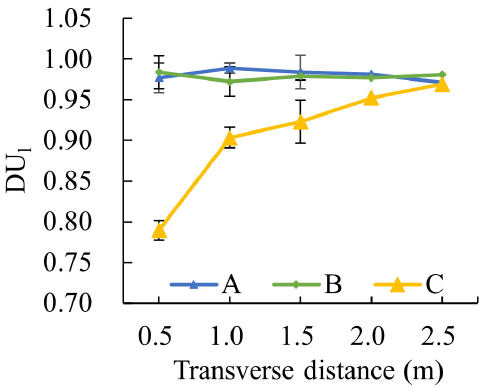
Figure 9. Transverse distribution uniformity in the test plots.